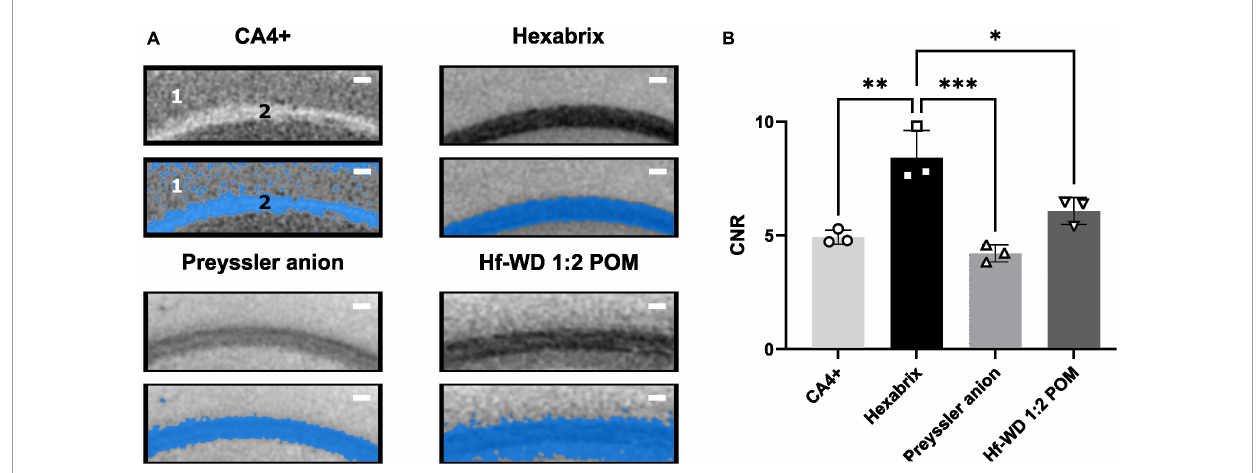
FIGURE6 Comparison of ease of segmentation per CESA based on CNR. (A) Illustration of the effect of the ease of binarization between white matter (corpus Callosum) and gray matter (cerebral cortex) using automatic thresholding (Otsu criterion). 1 = Cerebral cortex, 2 = Corpus callosum. Scale bar = 100 µ m. (B) CNR values for gray and white matter comparison for all CESAs. Ordinary One-Way ANOVA ( α = 0.05, p -value = 0.0005) followed by Tukey’s multiple comparisons test ( n = 3, Hexabrix vs CA4+: p -value = 0.0015, 95%CI [1.619, 5.356]; Hexabrix vs. Preyssler anion: